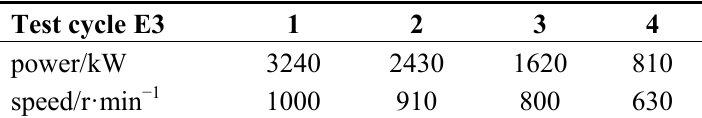
Table 2. Test cycle E3 for a 16V240 diesel